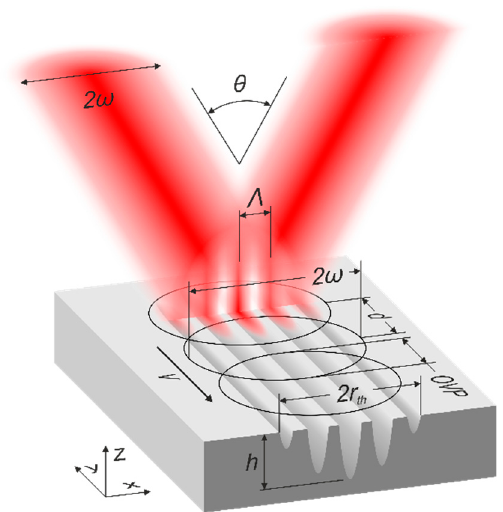
Figure 1. Graphical representation of the used two-beam direct laser interference patterning (DLIP) process, showing the most relevant parameters describing both the pattern and the process: ω —beam radius; θ —beams intersection angle; Λ —laser intensity profile / ablated structure period; d—distance between the laser spots; OVP —spot overlap; v —samples’ translation speed; rth—radius of ablated area; h—ablated structure depth.